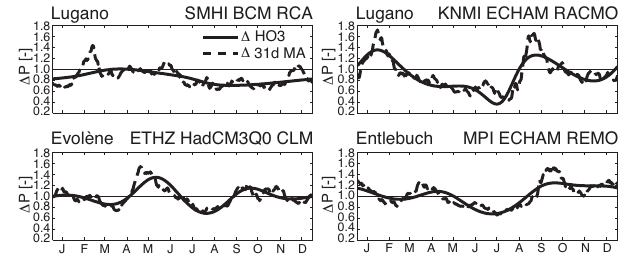
Fig. 5. Examples of ∆ P as estimated by a 31d MA (dashed lines) and the spectral smoothing (solid lines) of various model chains at different station sites as indicated in each panel’s title. Examples are shown for the SCE period 2070-2099.